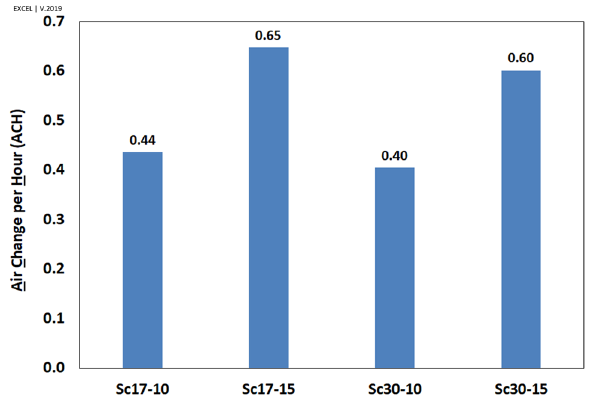
Figure 22. Air change per hour (ACH) in the windmill in different